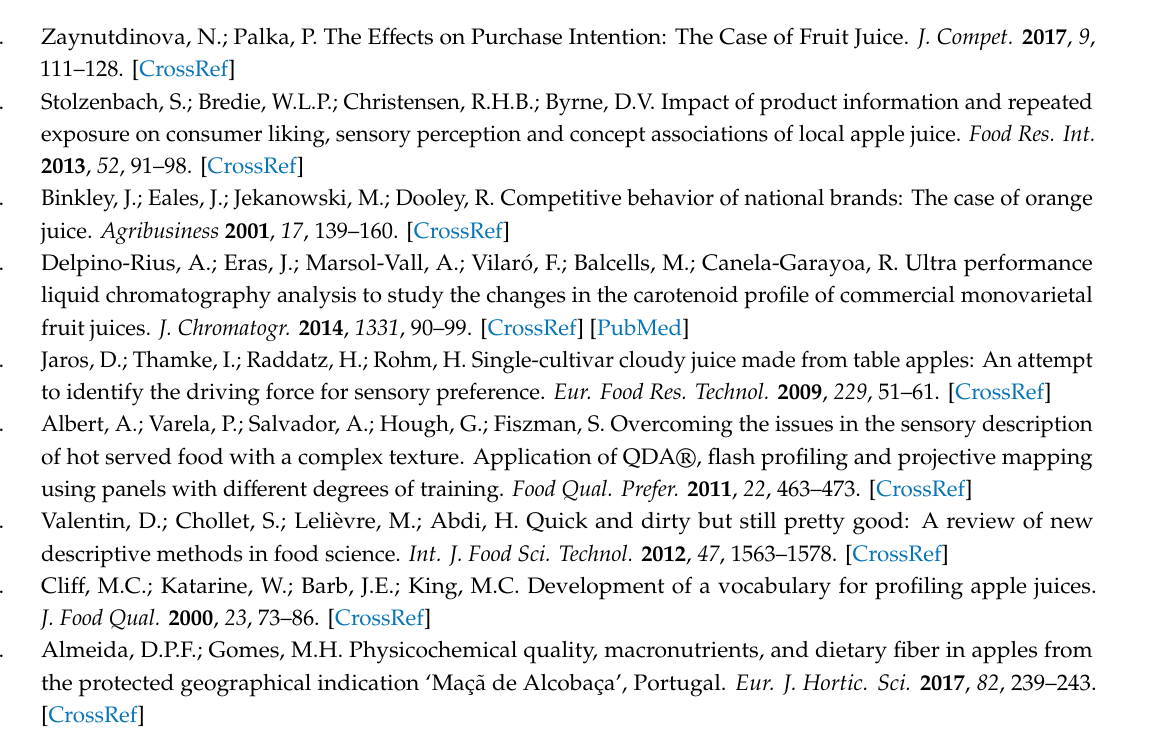
Figure S1: Results of dry matter were consistent with TSS values for all